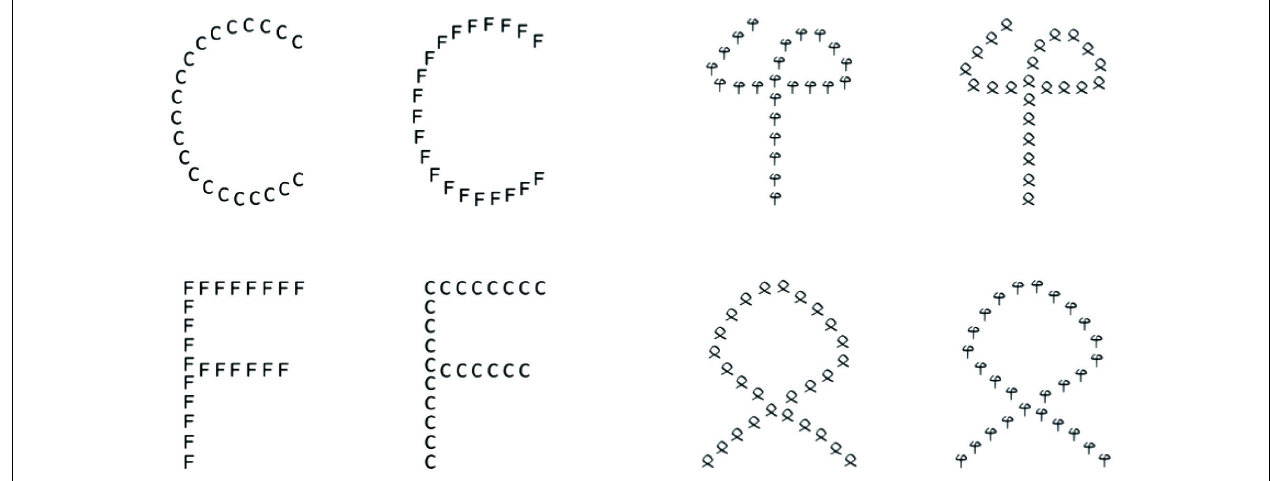
FIGURE 1 | Illustration of the hierarchical stimuli used in the experiment, left side: letters, right side non-letters. Leftmost column: congruent letter stimuli, of which the local and the global level consists of the same letters, C